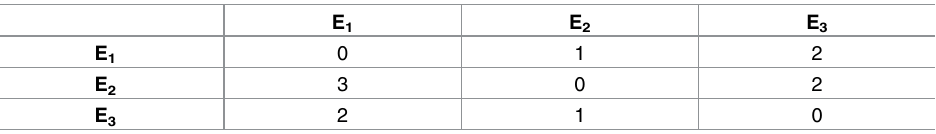
Table 4. The averageddirect-relation matrix for the